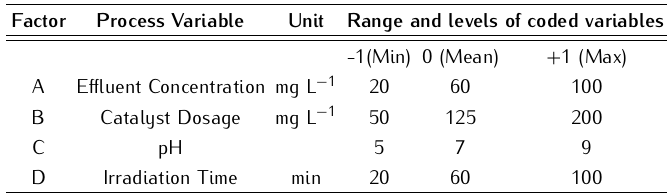
Table 2. Level and Experimental range of independent variables tested (coded and uncoded values).